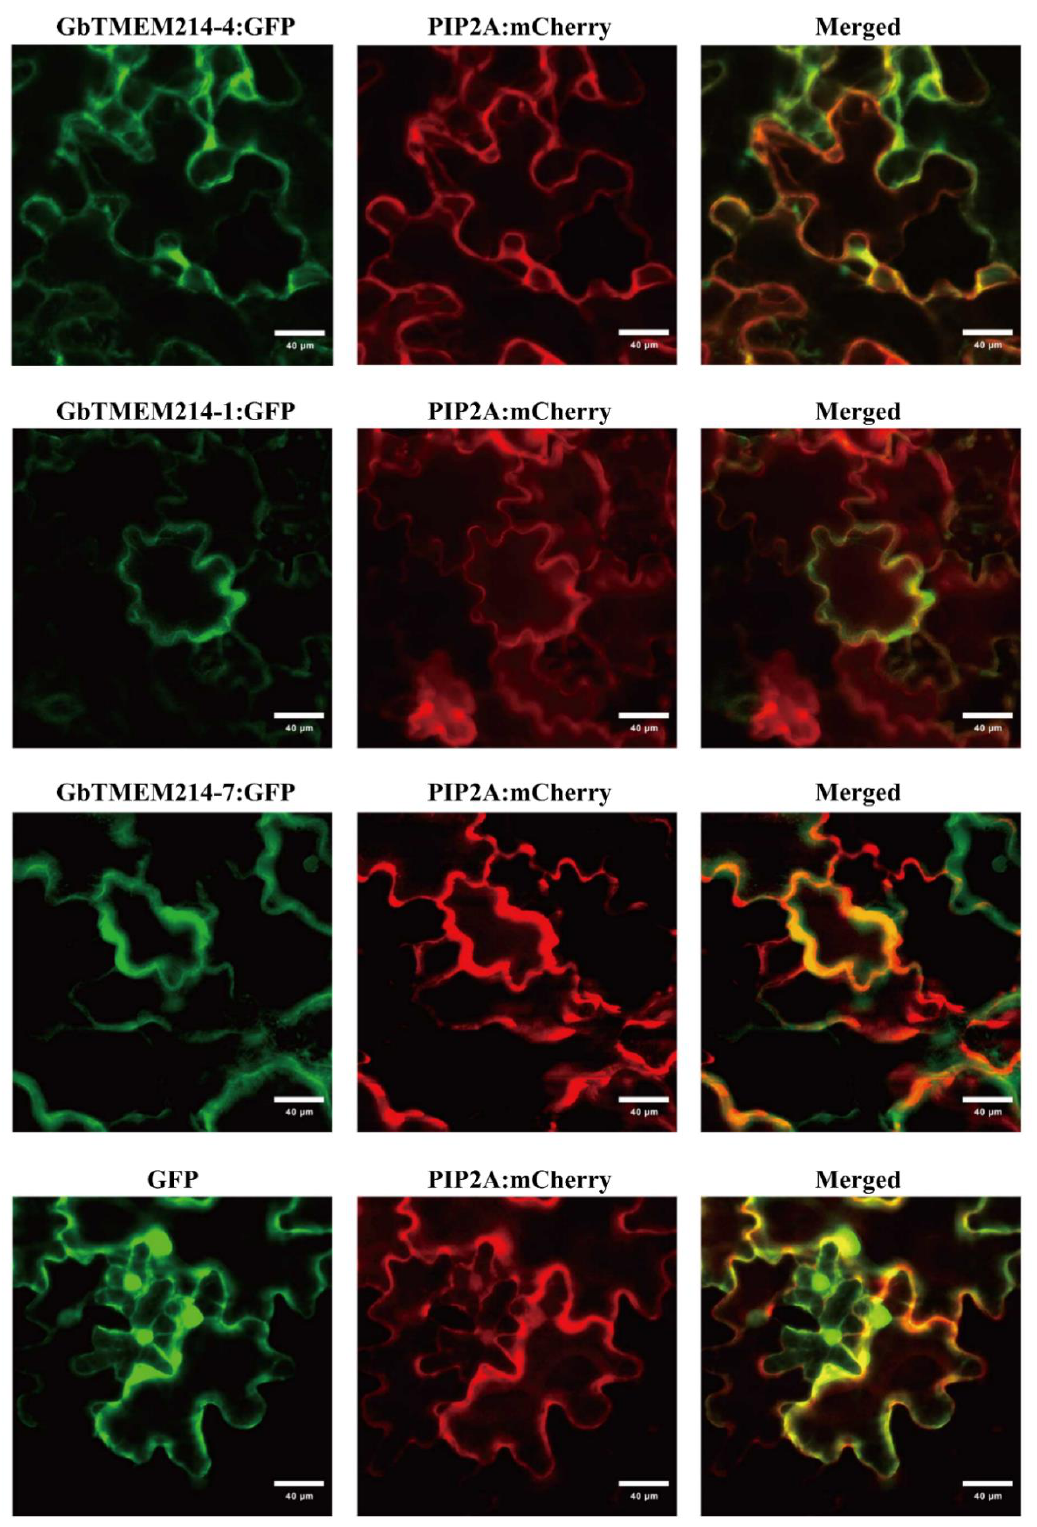
Figure 4. The subcellular localization of GbTMEM214s. The subcellular localization of GbTMEM214s-GFP in tobacco leaves. The constitutive GFP serves as a control. AtPIP2A-mCherry was used as a membrane-localization marker. The constructs were transiently expressed in N. benthamiana leaves. The green signal of GFP was fused with the red signal of membrane marker to determine the localization of the protein. Bars = 40 µm.